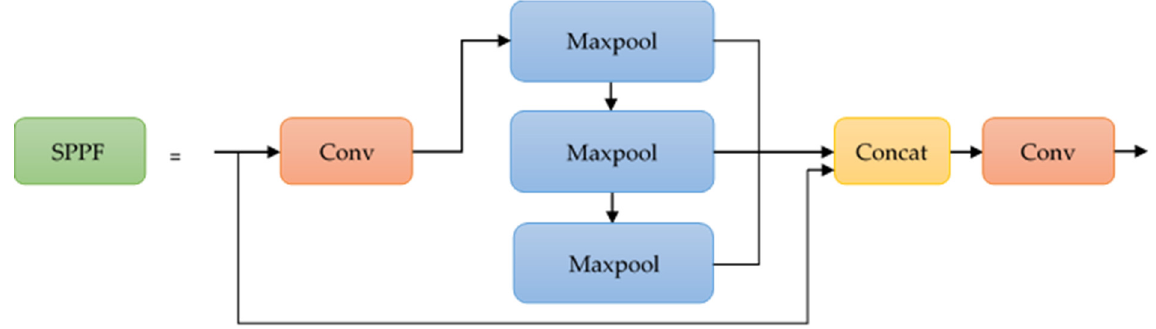
Figure 4. The improved Yolov5s-CA network model structure.